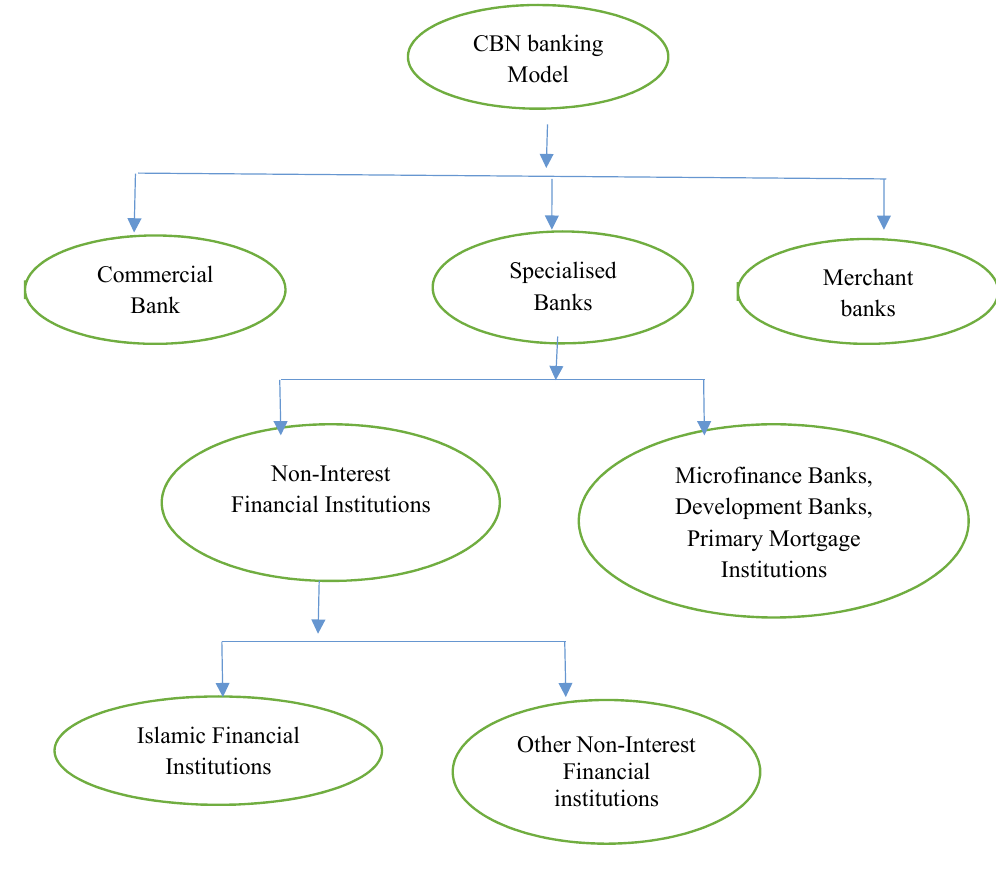
Fig. 1. Model for Islamic financial institutions (CBN,